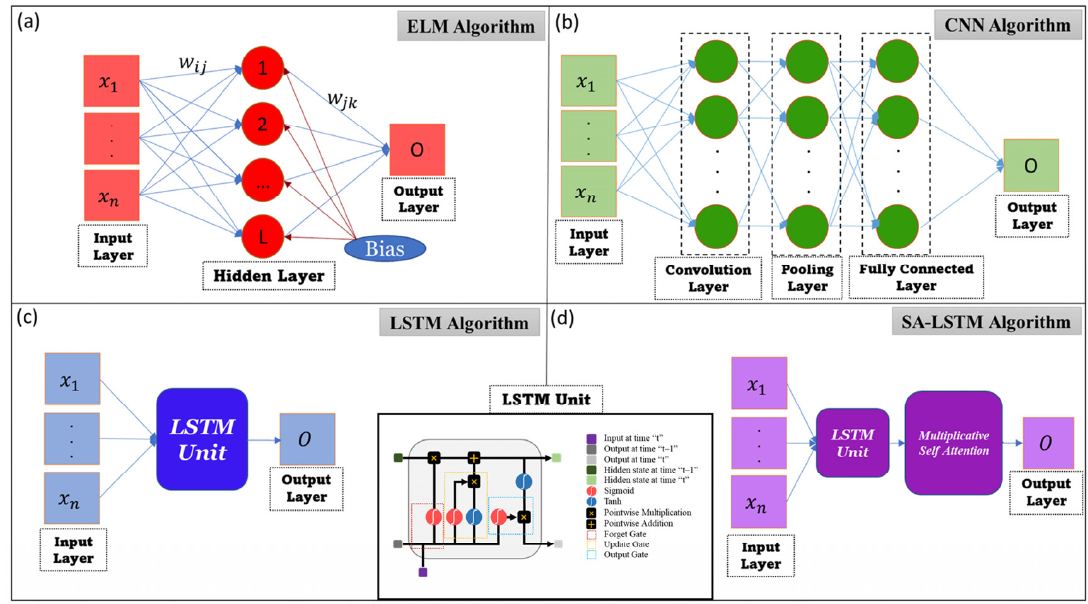
Figure 4. The model architectures for the investigated algorithms in this study.